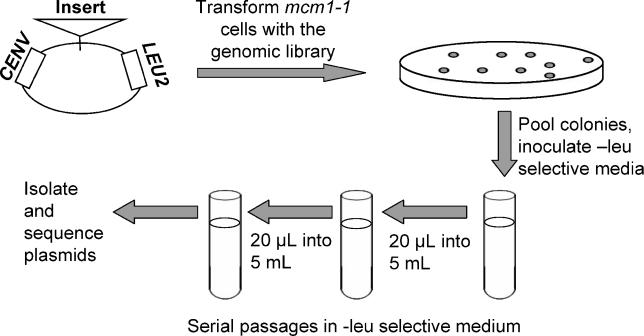
Serial Passages of a Plasmid Library of Genomic DNA in mcm1–1 Cells to Enrich for Stable Plasmids Containing A-Type ARSs